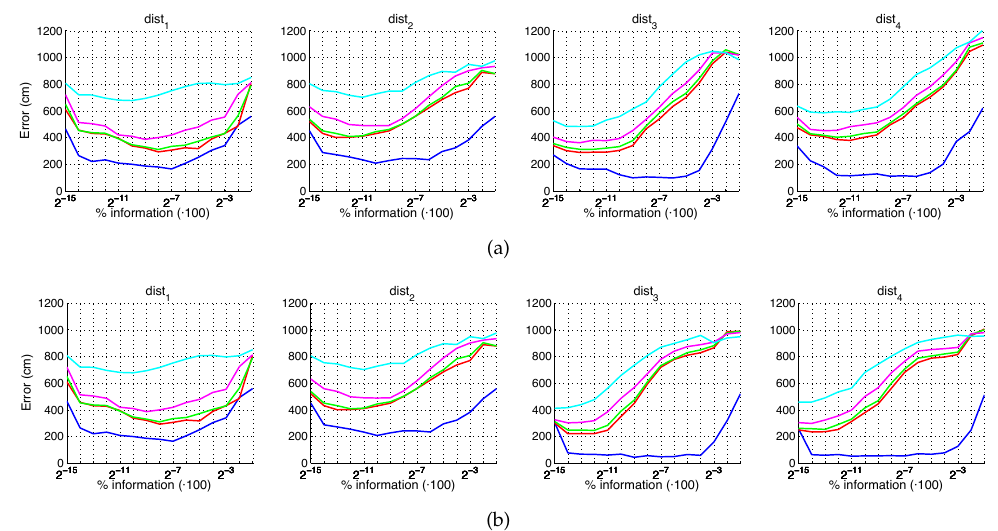
Figure 23. HOG average localization error with occlusions: ( a ) no filter and ( b ) homomorphic filter. Legend: —– Original, —– Occlusion 1, —– Occlusion 2, —– Occlusion 3, —– Occlusion 4. Additionally, Figures 24 and 25 present the results obtained with gist considering the presence of noise or occlusions, respectively, in the test images. In these figures, first, no filter is considered (a) and second, a homomorphic filtering is carried out both to the reference and the test images (b). Like in the case of FS, the percentages of information contained in each descriptor with respect to the information contained in each panoramic improve the localization results in any case. In the presence of noise, dist 3 presents the best results when considering an intermediate percentage of information.